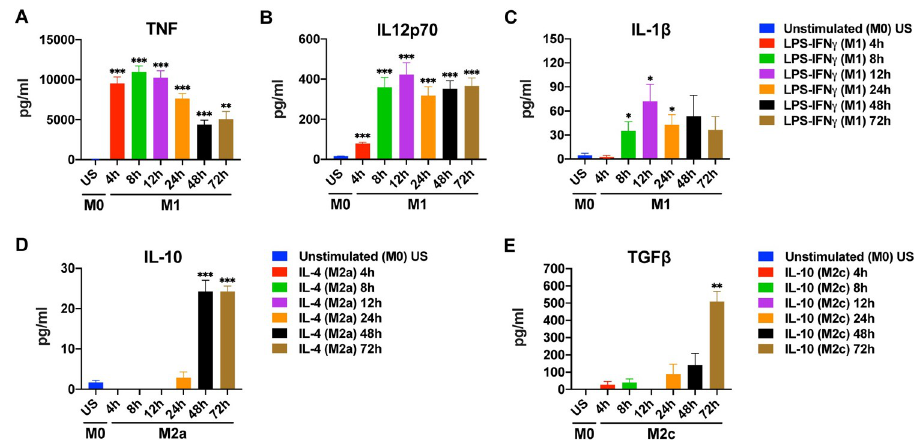
Fig 3. Time depended changes in cytokine production by M1, M2a, and M2c macrophages. Primary human MDMs (M0) were left unstimulated or were polarized to M1 (100 ng/mL LPS, 20 ng/mL IFN γ ), M2a (20 ng/mL IL-4), or M2c (20 ng/mL IL-10) for 4, 8, 12, 24, 48, or 72 h. Production of (A-C) TNF, IL-12 and IL-1 β for M1 polarization; of (D) IL-10 for M2a polarization, and of (E) TGF β for M2c polarization was analyzed by ELISA. Data shown are mean ± SEM of biological replicates of 3 independent donors. Polarized macrophages (M1, M2a, or M2c) at all time points were compared with unstimulated (US) M0 macrophages. Trends for individual donors are depicted in S3 Fig. Statistical analyses were performed with repeated measures ANOVA, � p < 0.05; �� p < 0.01; ��� p < 0.001 (Statistical comparison of all time points are shown in the S3